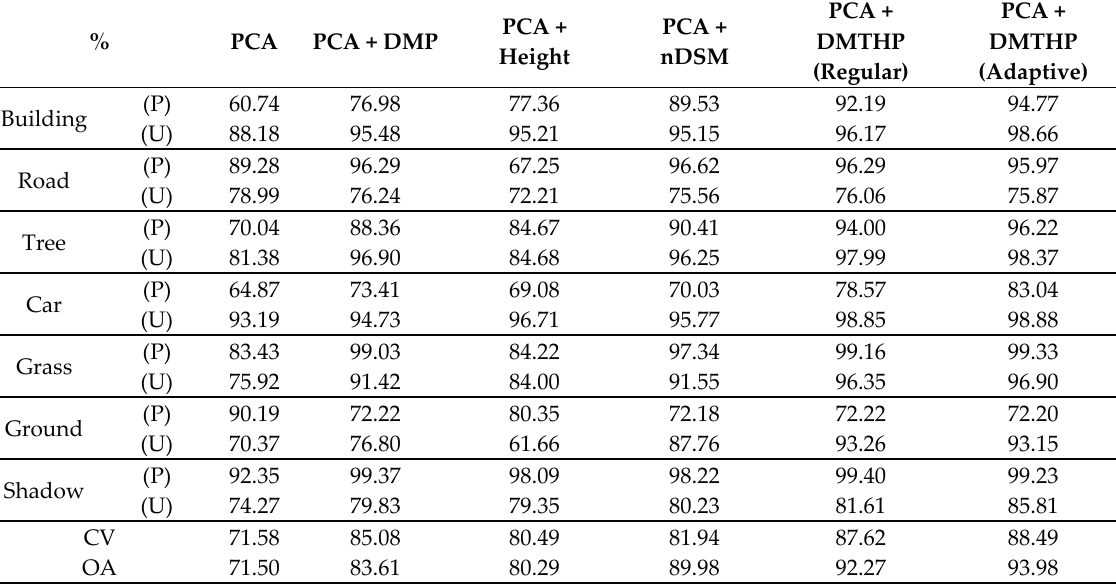
Table 4. Comparative Results of Experiment 1 (per-class producer’s (P) and user’s (U) accuracy). %